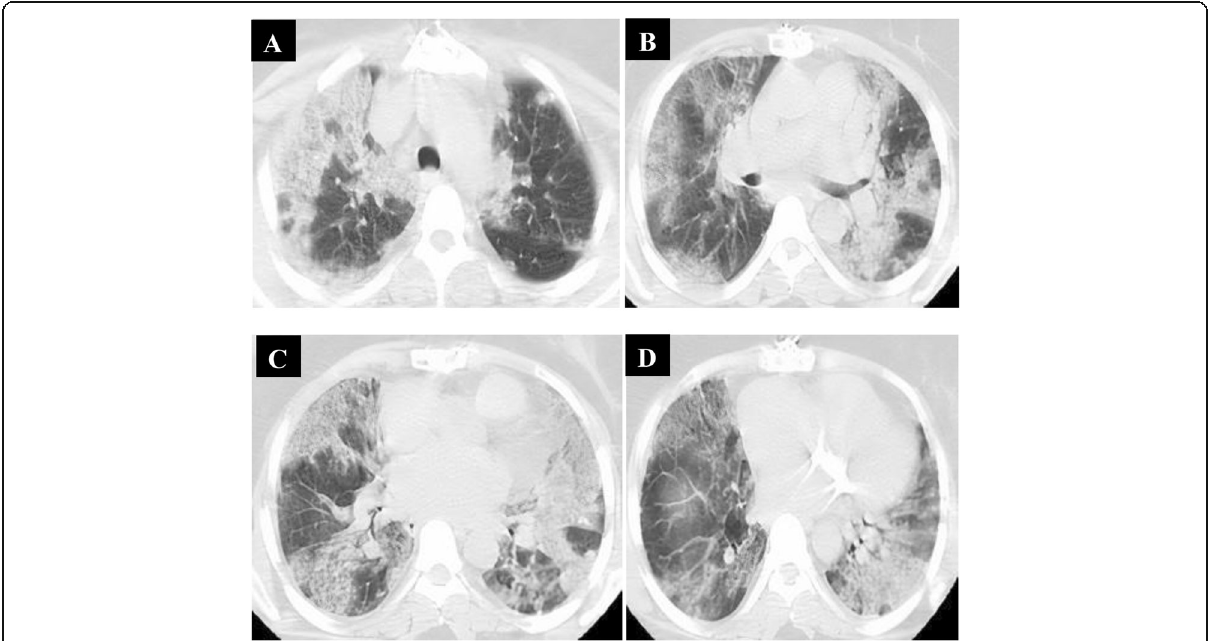
Fig. 5 A 36-year-old female patient complaining of dyspnea, fatigue, fever, and cough (severe symptoms). Non-contrast axial chest CT ( a , b ) 1 day from the onset of symptoms (early phase) revealed normal CT study. With the persistence of the same symptoms, follow-up chest CT ( c – f ) 6 days from onset of symptoms revealed multiple extensive confluent patchy areas of ground-glass opacities and consolidation seen scattered at both lungs: central and peripheral in